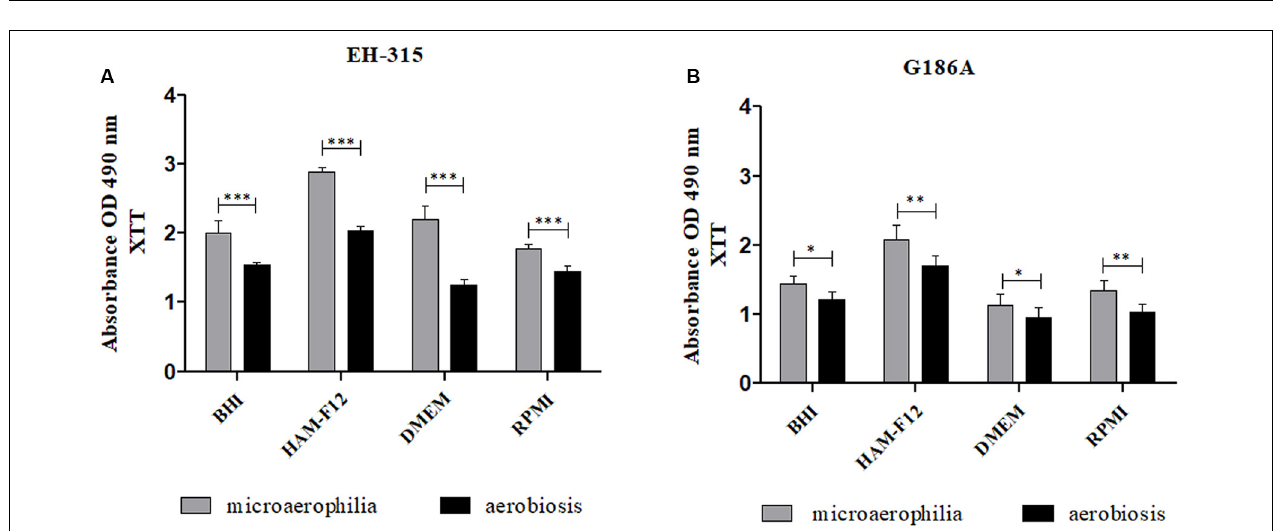
FIGURE 2 | Comparison between the metabolic activities of biofilms formed by the strains H. capsulatum EH-315 (A) and G186A (B) in different culture media and under different oxygen atmospheres. * p < 0.05, ** p < 0.01, and *** p < 0.0001.